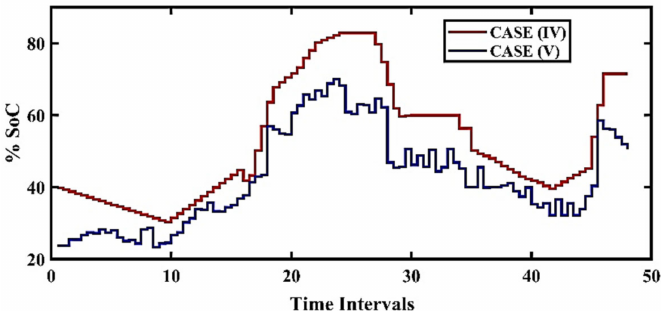
Figure 12. SoC statistics at various instants for cases (I) and (IV).